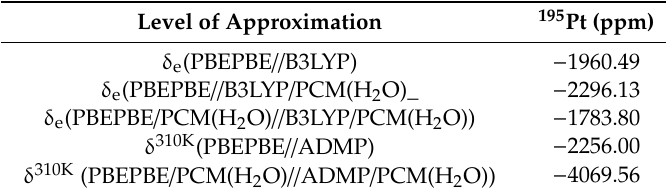
Table 1. 195 Pt NMR chemical shifts for Complex (Figure 1) computed at the GIAO–PBEPBE / NMR-DKH. Level of